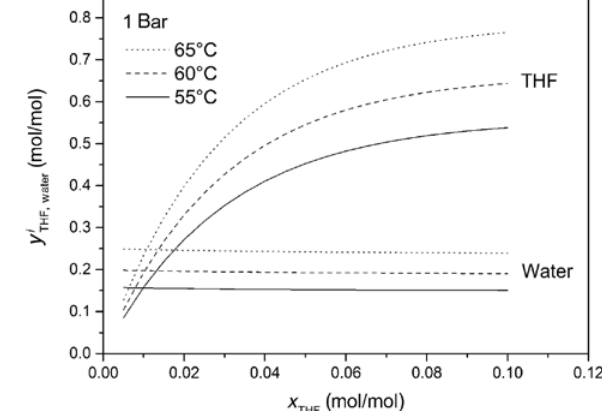
Figure 2: THF and water fraction in the gas at the gas-liquid